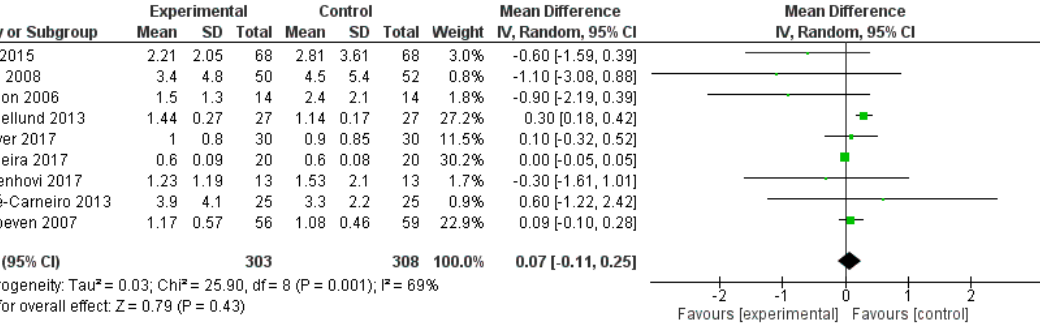
Figure 7. Pooled analysis of association between polyphenol intake and high-sensitive C-reactive protein (hs-CRP).